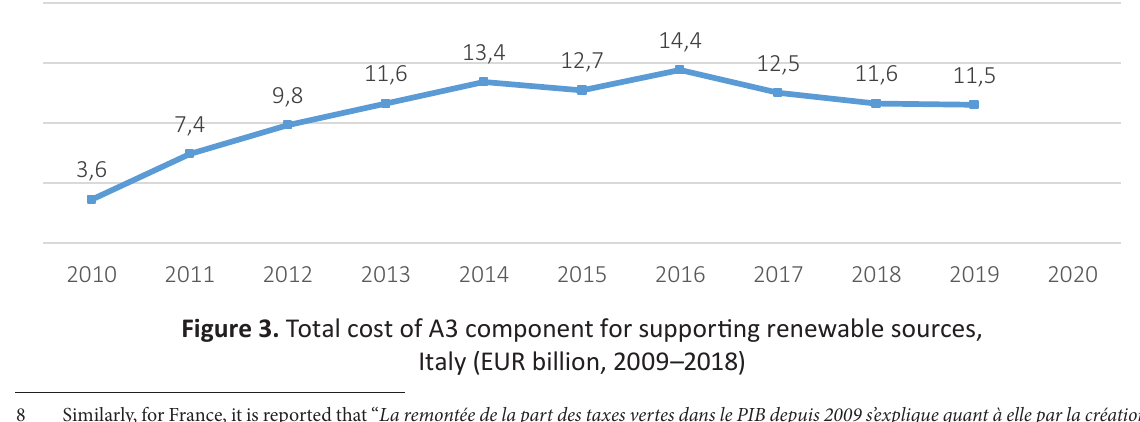
Figure 3. Total cost of A3 component for supporting renewable sources, Italy (EUR billion, 2009–2018)